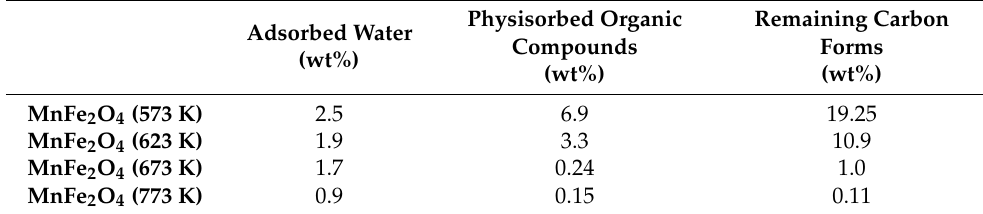
Table 3. The weight losses of the ferrite samples.